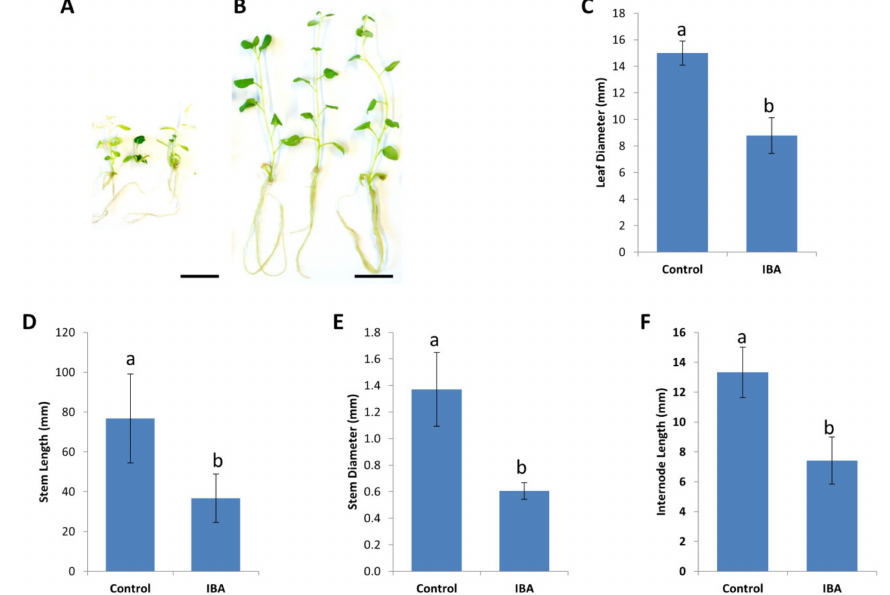
Figure 2. Long-term e ff ects of the auxin Indole-3-butyric acid (IBA) on the morphological and physiological characteristics of Solanum tuberosum cv. King Edward in-vitro. ( A ) In-vitro propagated S. tuberosum cv. King Edward on media containing 0.2 mg / L IBA displaying aberrant shoot morphologies, after 4 months of in-vitro culture. ( B ) In-vitro propagated S. tuberosum cv. King Edward stock lines on agar media containing no IBA, displaying typical shoot morphology. Bar = 20 mm. E ff ects of IBA on the ( C ) leaf diameter, ( D ) stem length, ( E ) stem diameter, and ( F ) internode length, after 4 months of continuous culture on media containing 0.2 mg / L IBA. Results are expressed as mean ± standard deviation. Thirty explants were observed for each treatment and the experiments were repeated twice. Bars denoted by di ff erent lowercase letters a and b indicate a significant di ff erence at p < 0.05, through one-way ANOVA for each part of the figure